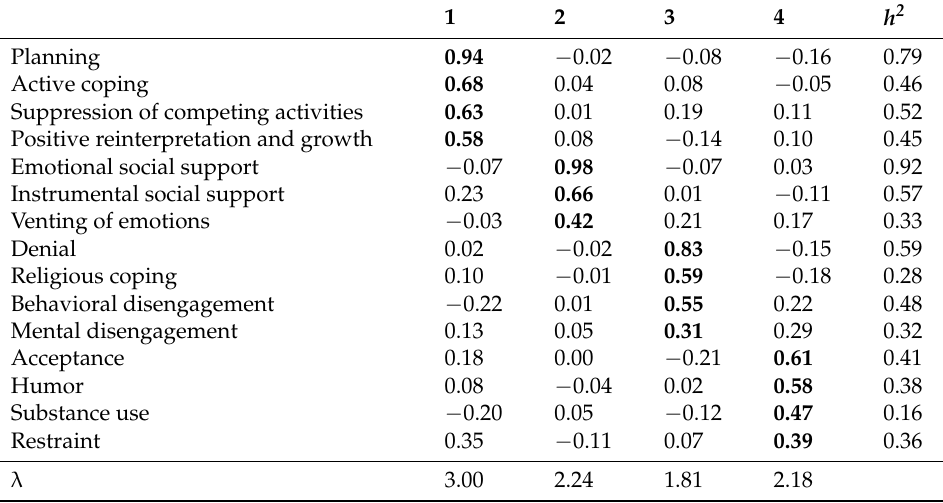
Table 3. Pattern matrix for coping